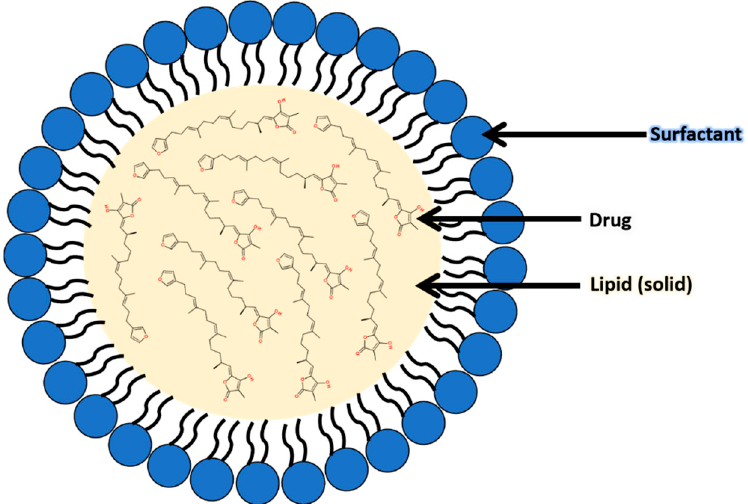
Figure 2. Schematic of a variabilin-loaded solid lipid nanoparticle.